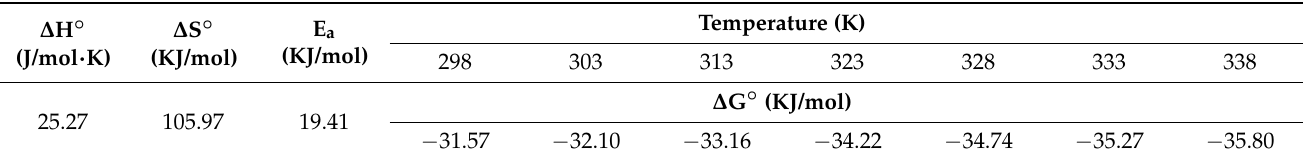
Table 2. Calculated thermodynamic parameters of heparin adsorption over ZIF-8.